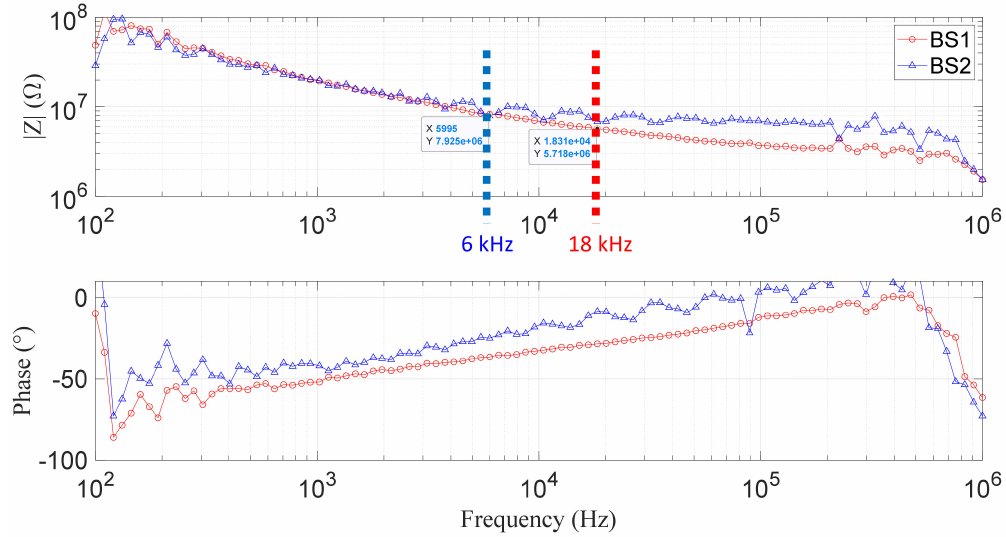
Figure 7. The impedance spectrum of the biosensor without the insulation layer B s ( blue ) and with the insulation layer B W_insu ( orange